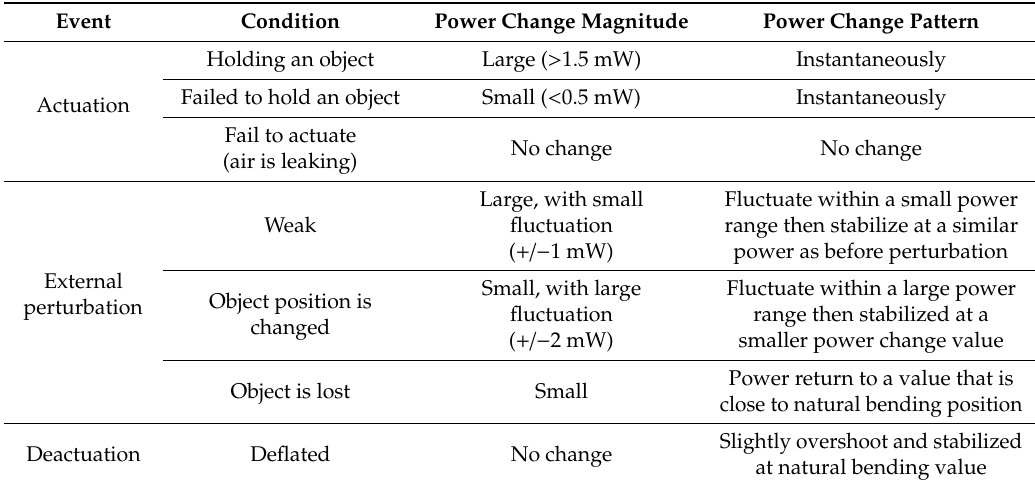
Table 3. Power change (comparing with natural bending value) observation under various movements and status change of the soft gripper.